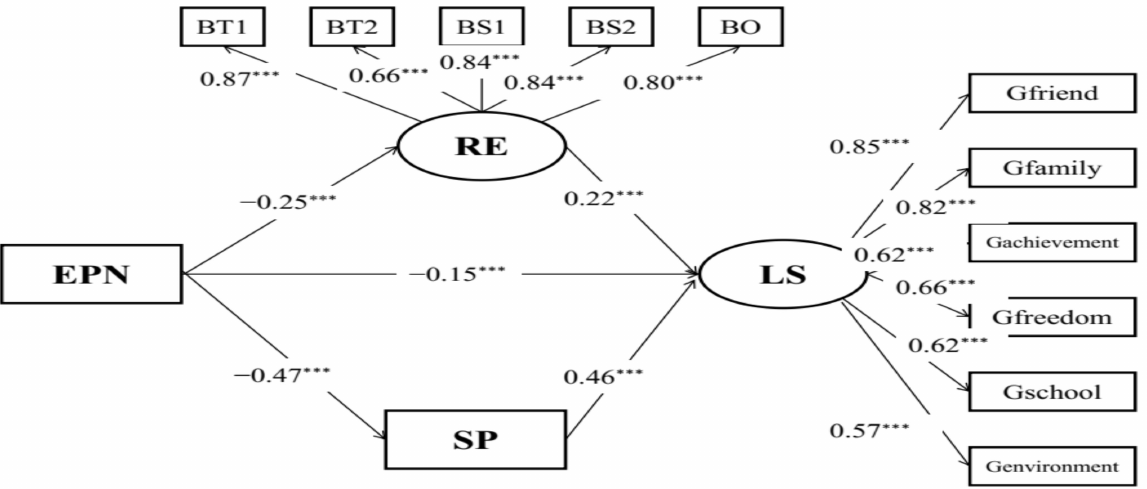
Figure 6. Mediation model of physical neglect, life satisfaction, resilience, and social support. EPN: physical neglect; BT1: tenacity 1; BT2: tenacity 2; BS1: strength 1; BS2: strength 2; BO: optimism; LS: life satisfaction; RE: resilience; SP: social support; *** p < 0.001.